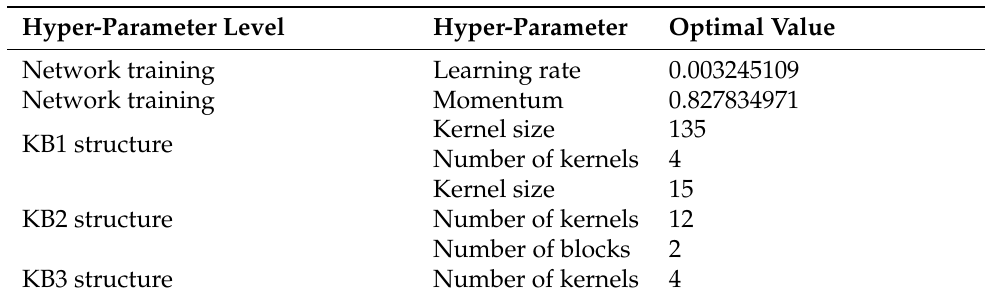
Table 6. Optimal hyper-parameters values of